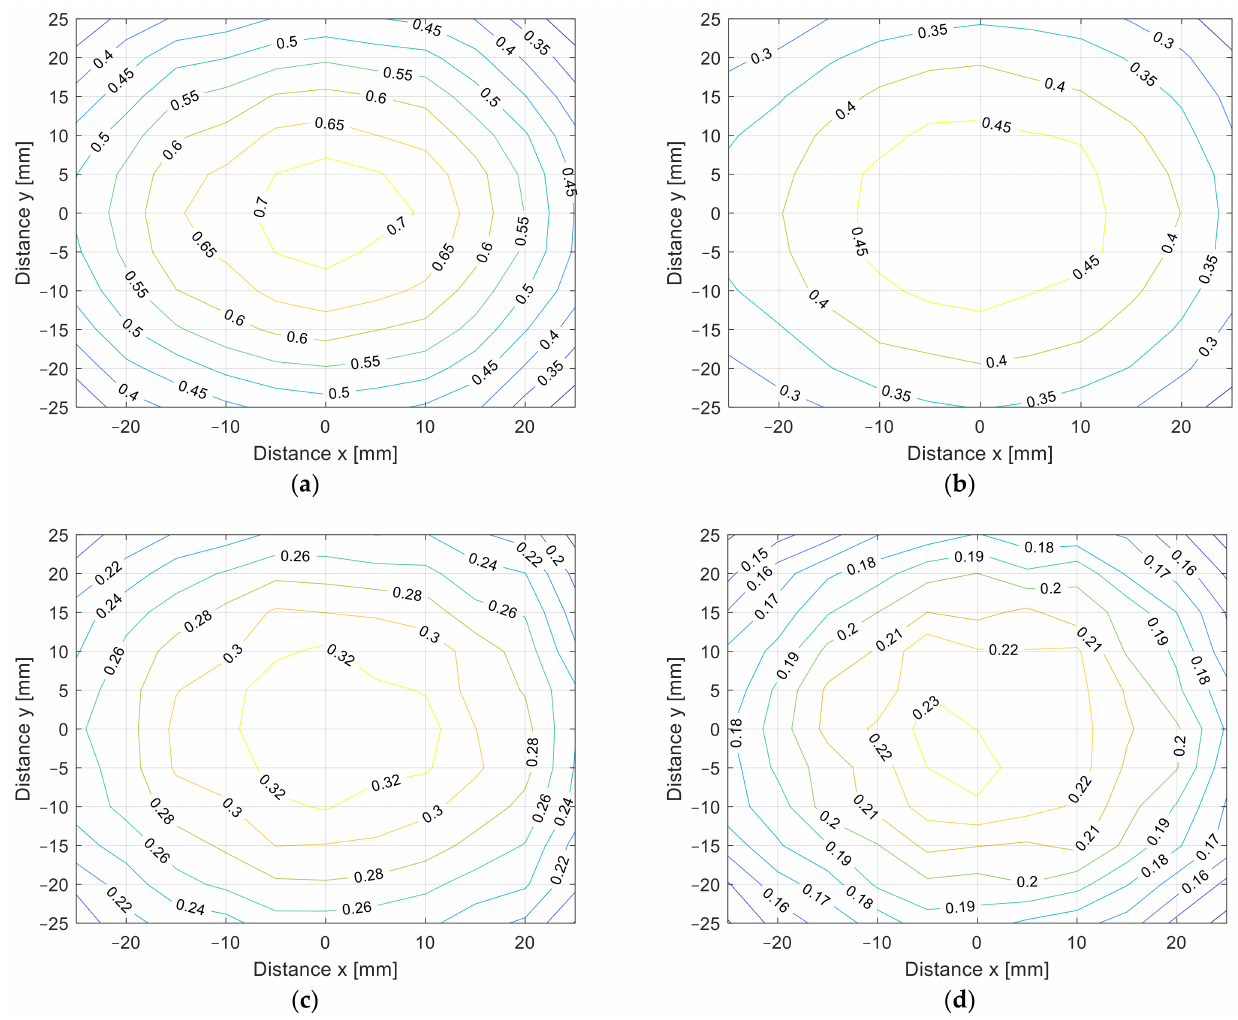
Figure 11. x - y coupling coefficient measurement of planar square coils (contour plot). ( a ) At